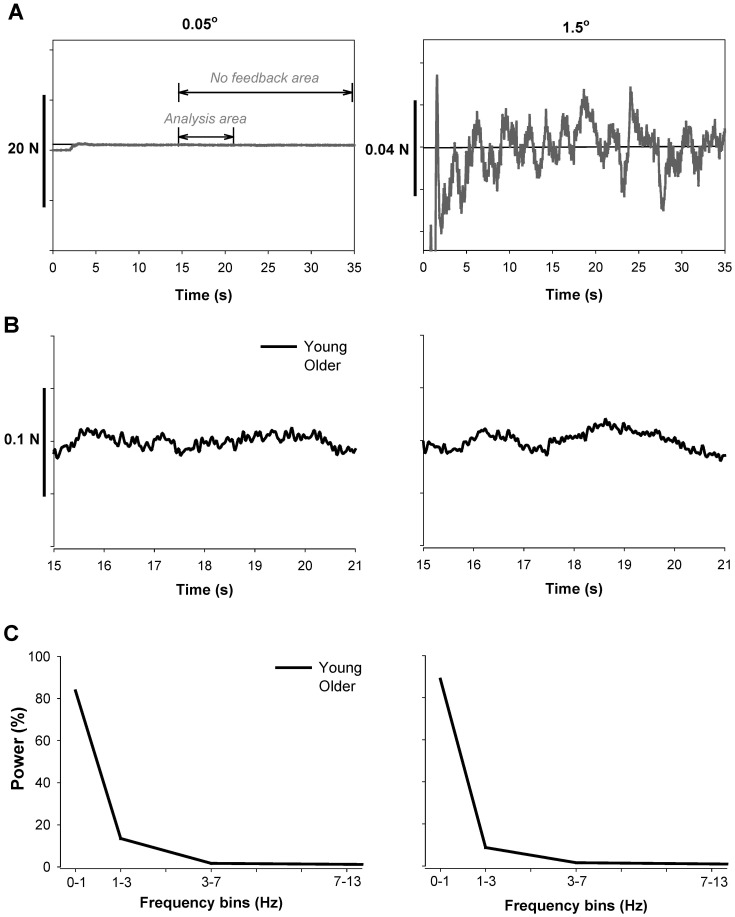
Representative trials from a young and an older adult exerting a constant force at 2% MVC with low (visual angle = 0.05°, left column) and high (visual angle = 1.5°, right column) magnification of visual feedback.A: Each subject performed a constant isometric contraction by abducting their left index finger against a force transducer. Subjects were instructed to match a line representing their force to a horizontal target line for 35 s. Visual feedback of the target line and exerted force was provided throughout the entire trial during visual feedback conditions. During no visual feedback trials, feedback was removed (no feedback area) after 15 s. B: Representative force output from a young and an older adult is shown. Data analysis was based on force output from 15–21 s (analysis area). Older adults exhibited greater variability of force with higher magnification of visual feedback (higher visual angles of 0.5° and 1.5°). C: Representative normalized power spectrum of the force output from 0–13 Hz in a young and an older adult during trials with low and high magnification of visual feedback. The majority of the power (∼85%) in the force output occurs from 0–1 Hz.